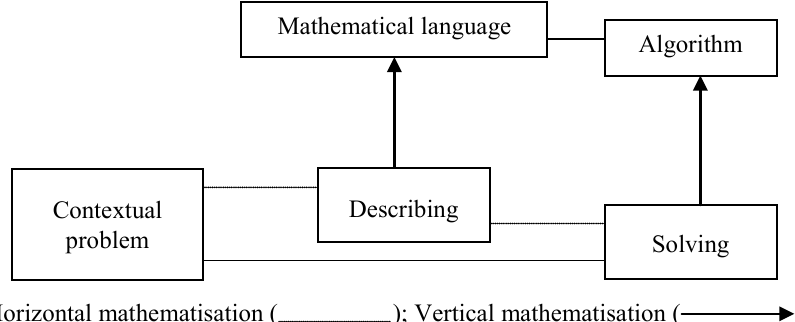
Figure 2: Horizontal and vertical mathematisation Source: Adapted from Gravemeijer,